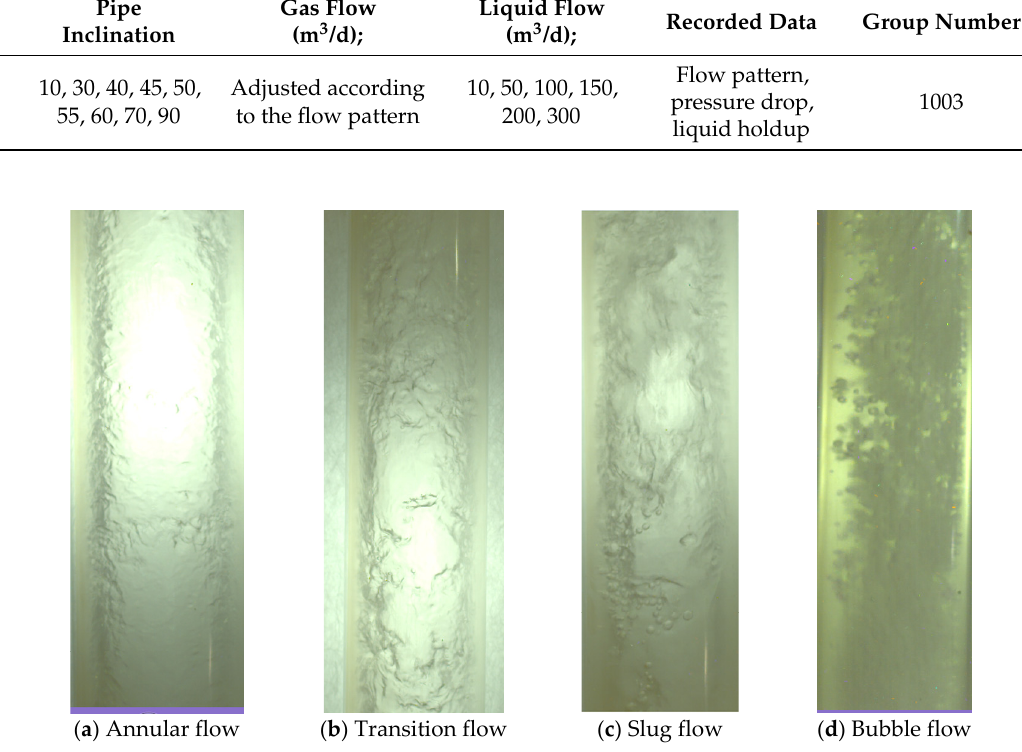
Figure 2. Flow pattern in the experiment (60 mm diameter; pipe inclination: 60°).